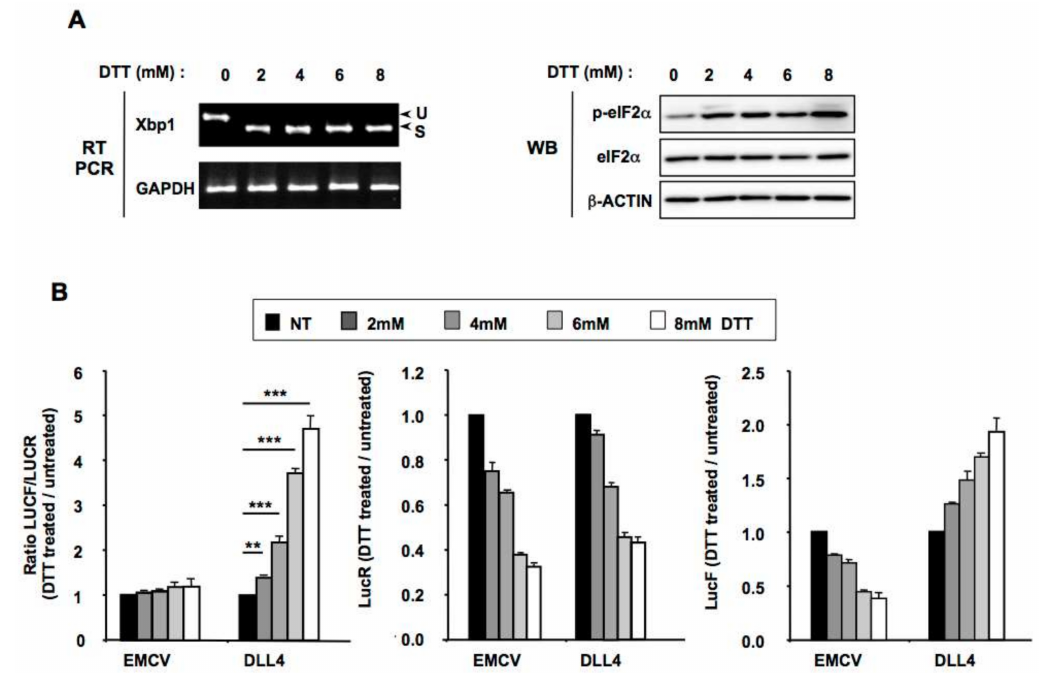
Figure 3. The DLL4 IRES is activated by ER stress. HeLa cells were transfected by bicistronic constructs containing either the EMCV or the DLL4 IRES and treated or not for 6 h with increasing concentrations of DTT. ( A ) ER stress induction was verified by monitoring both cytoplasmic XBP1 splicing by RT-PCR and eIF2 phosphorylation by western blotting ( B ) Relative luciferase activities (LucR, LucF or LucF/LucR ratio) after ER stress induction by treatment with increasing amounts of DTT for 6 h. IRES activities were determined by calculating the LucF/LucR ratios and are expressed as fold change versus untreated cells. The results represent the means of three independent experiments ( ± SEM), ** p < 0.01, *** p <